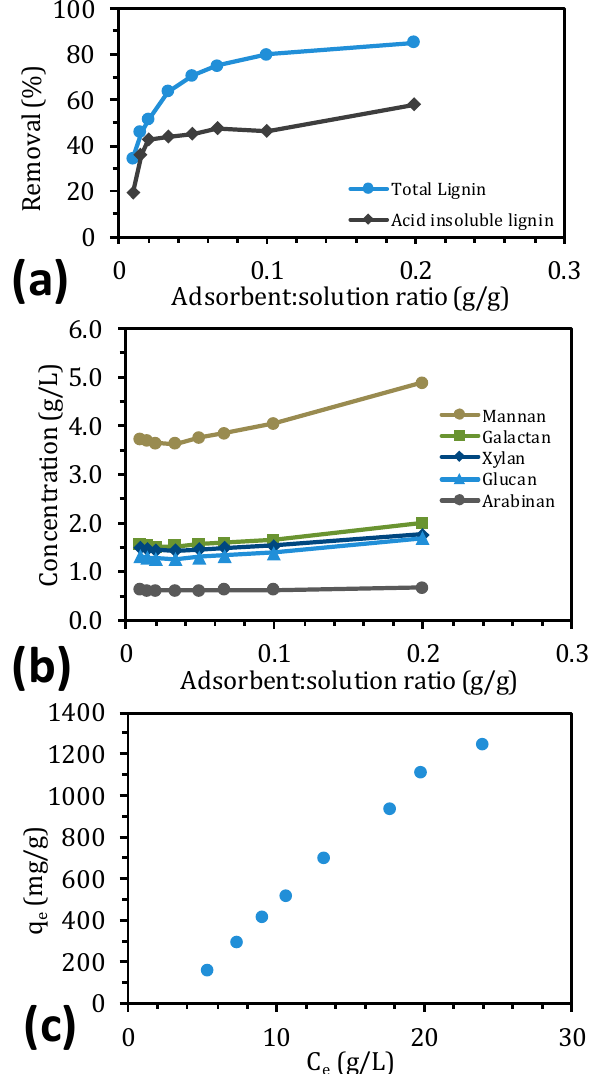
Figure 2. Lignin removal from solution ( a ) and the concentration of polysaccharides ( b ) at various adsorbent/solution ratios. ( c ) Amount of adsorbed lignin per gram of adsorbent (q e ) vs. the concentration at equilibrium (C e ).